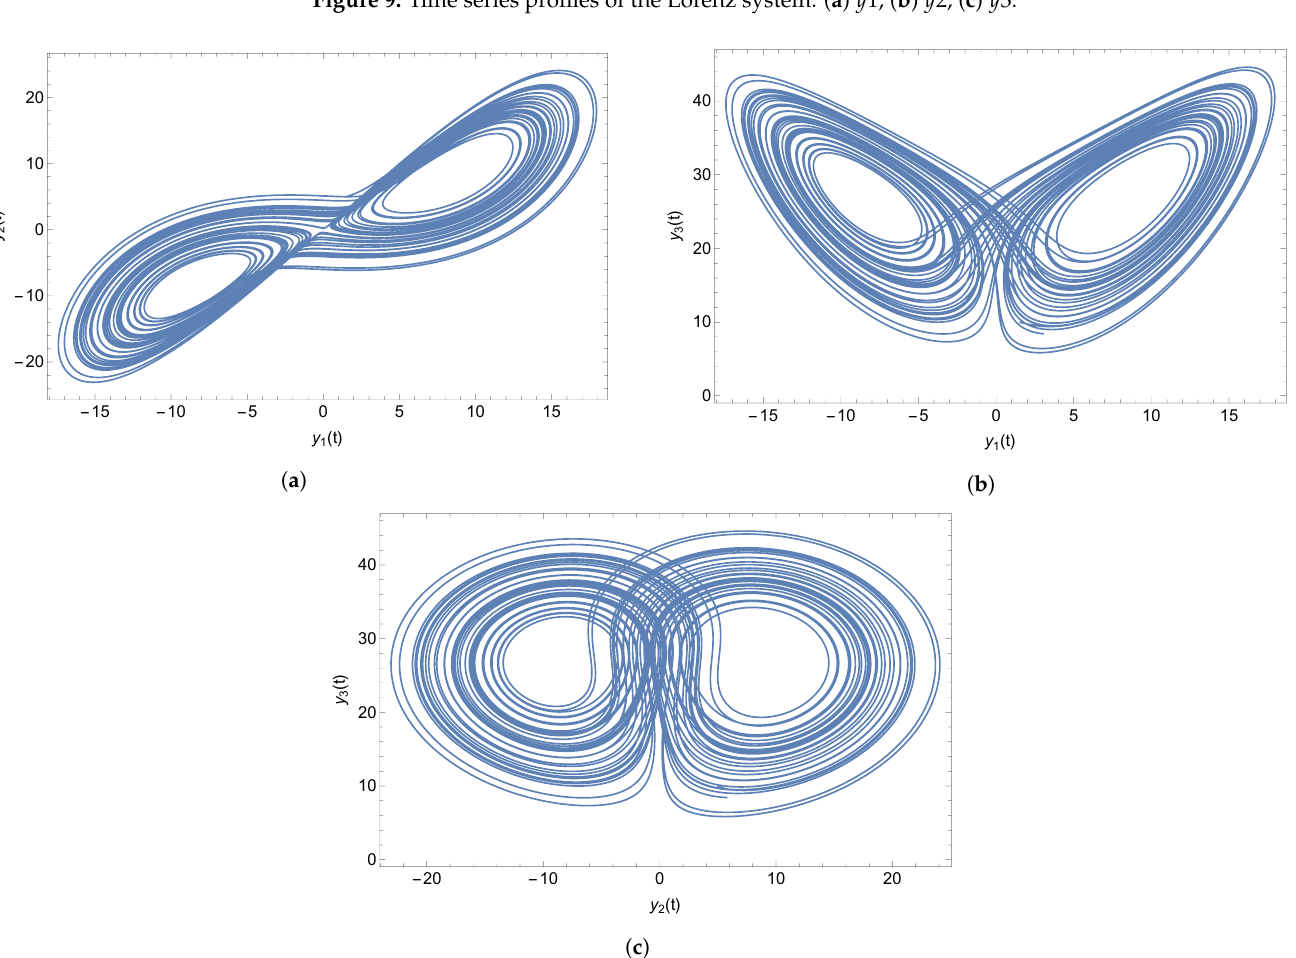
Figure 10. Phase portraits of the Lorenz system. ( a ) y 1 and y 2; ( b ) y 1 and y 3; ( c ) y 2 and y